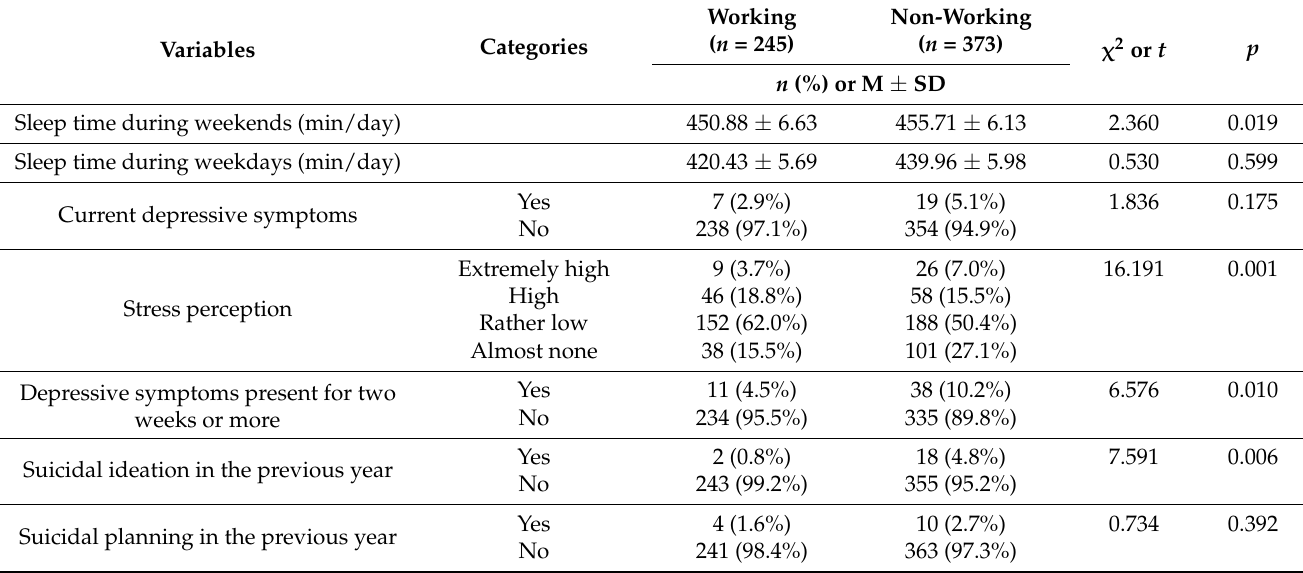
Table 3. Psychology-related variables depending on the occupational status, n =